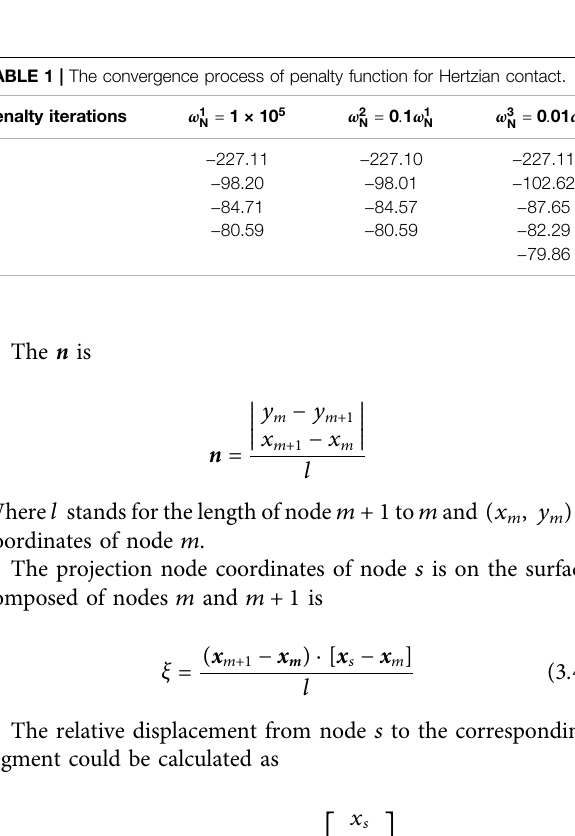
FIGURE 5 | Hertz contact model.